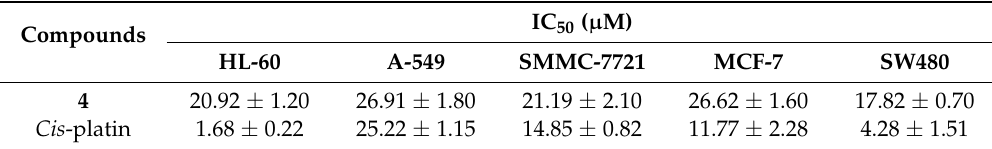
Table 4. Antitumor activities of compound 4 and the positive control cis